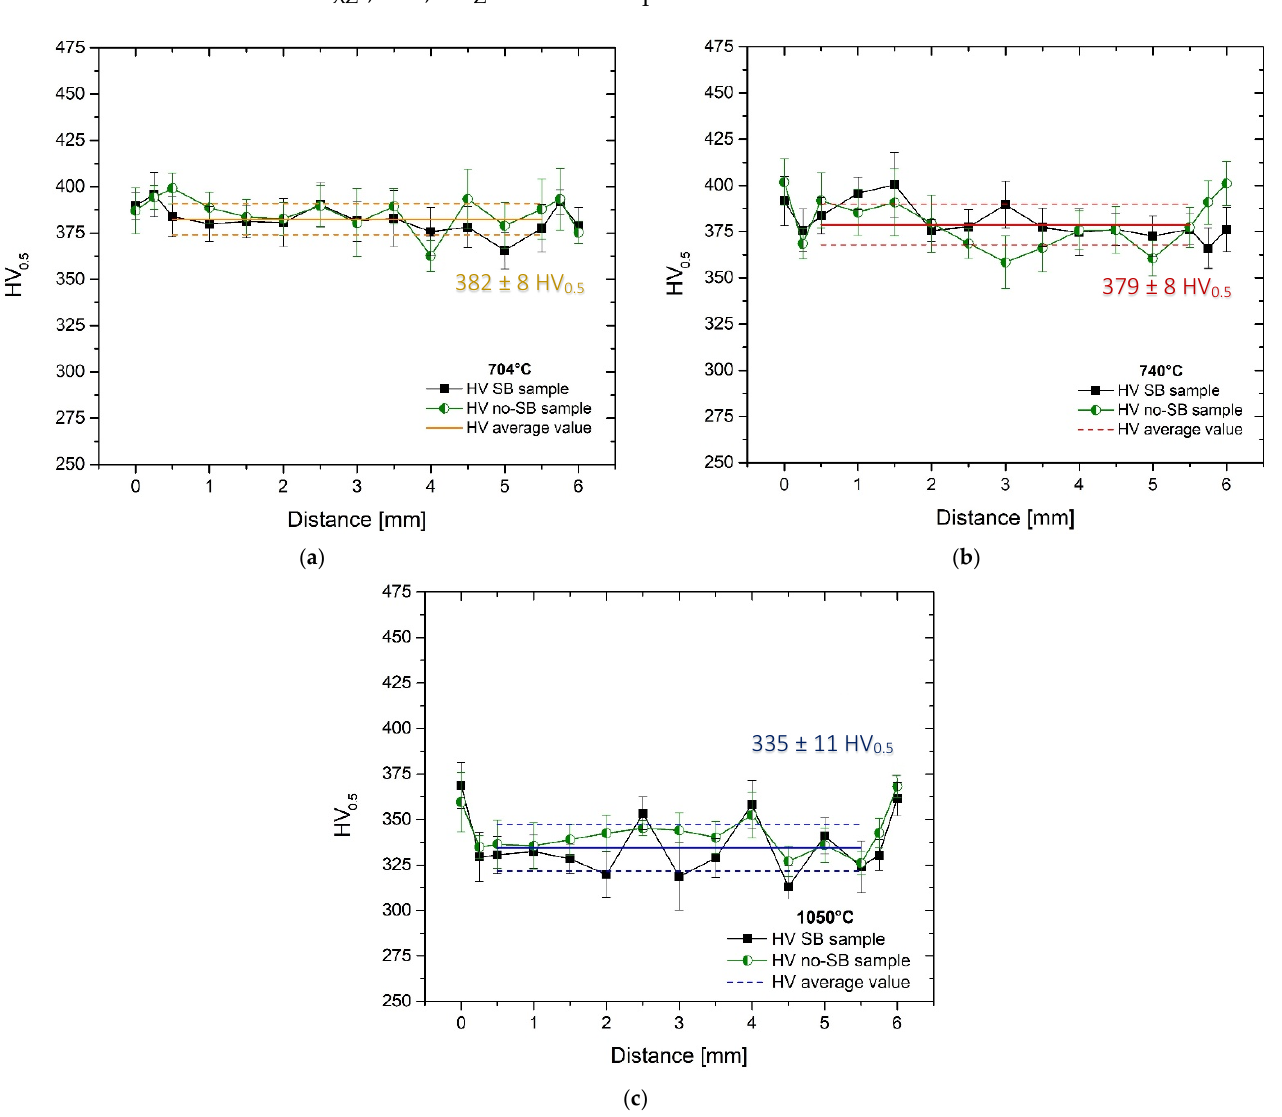
Figure 12. Vickers microhardness profile measured on the cross-section of 90° Z -samples heat-treated at: ( a ) 704 °C/120 ′ , ( b ) 740 °C/130 ′ and ( c ) 1050 °C/60 ′ . The orange, red and blue lines represent the HV 0.5 average values of the 3rd–13th indentations of the Vickers profiles, while the dotted lines show the associated error ranges. Table 5. HV 0.5 measurements performed on heat-treated 0° XZ -, 0° XZ -, 45°-, 90° Z -bars (xz and xy planes) and samples (xz plane) at 704 °C/120 ′ , 740 °C/130 ′ and 1050 °C/60 ′ .